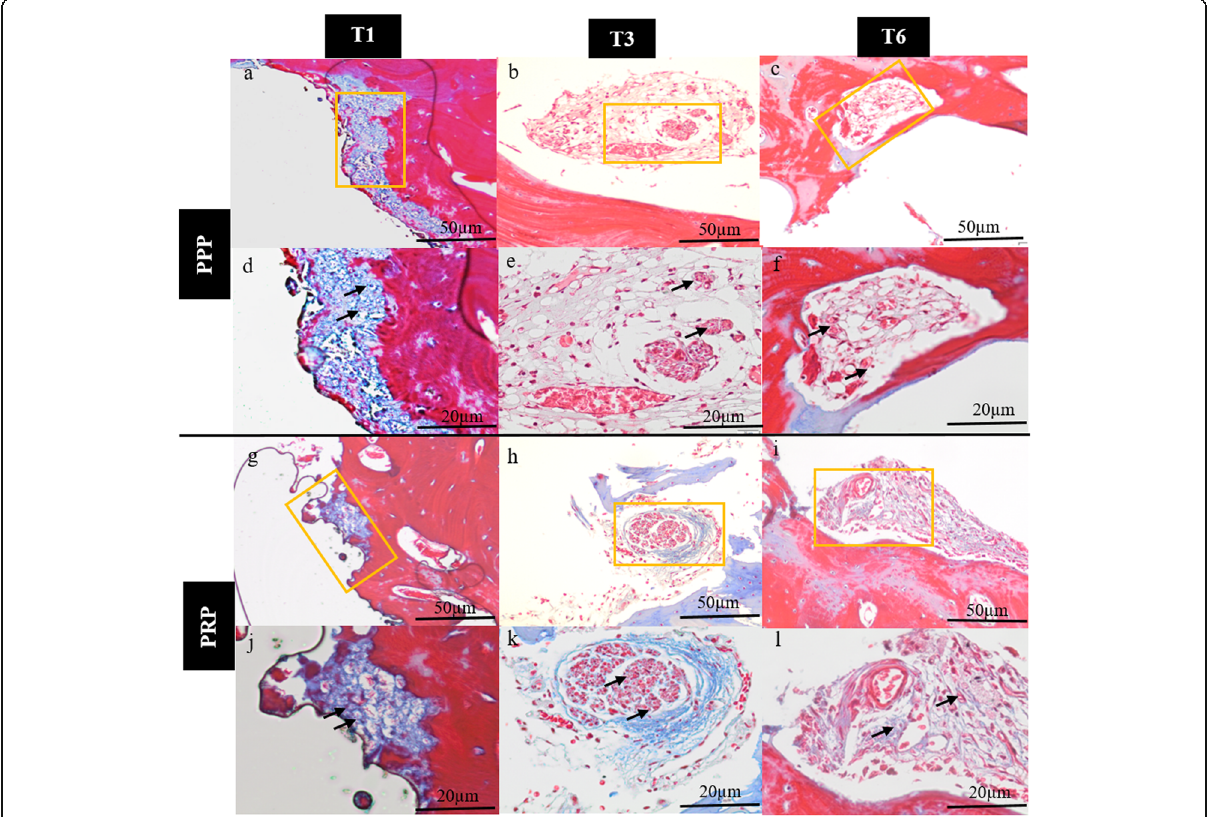
Fig. 4 Histological sections stained with Massons ’ s trichrome stain for platelet-poor and platelet-rich plasma after 1 (T1), 3 (T3), and 6 months (T6) healing time. The myelinated nerve fibers diameter (see arrows) increased with longer healing times for PPP ( d – f ) and PRP ( j – l ), but no effect was seen on nerve density ( a – c and g – i ). All sections were acquired with a light microscope at × 20 or × 40